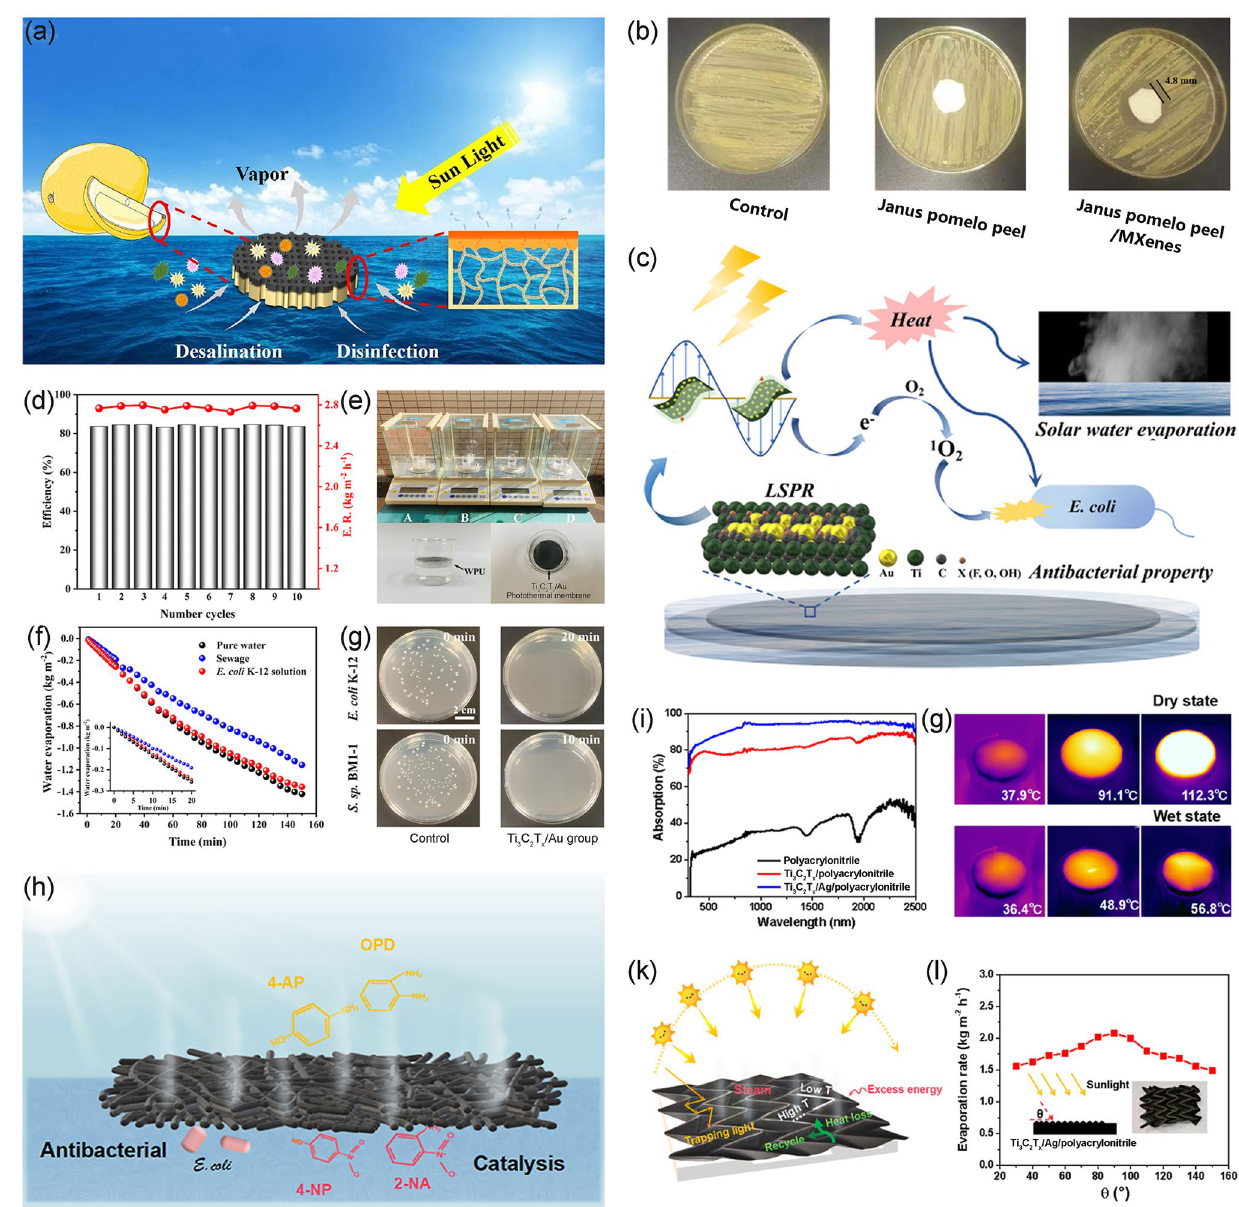
Fig. 12 a Schematic illustration of water evaporation and antibacterial property of Janus pomelo peel/MXenes; b Photographs of diffusion inhi- bition zone tests [155]. Copyright 2021 Elsevier. c Schematic illustration of solar water evaporation and antibacterial property of Ti 3 C 2 T x /Au photothermal membrane; d Solar evaporation rate (right axis) and the corresponding evaporation efficiency (left axis) of Ti 3 C 2 T x /Au photo- thermal membrane over 10 cycles (each cycle sustained over 1 h); e Photograph of the evaporation devices (A: control group, B: pure water, C: sewage from the Pearl River, D: E. coli K-12 solution); f Water evaporation performance of different solution systems; g Colony-forming units images of different bacteria after treatment with Ti 3 C 2 T x /Au photothermal membrane under irradiation [42]. Copyright 2021, American Chemical Society. h Schematic illustration of water evaporation and antibacterial property of Ti 3 C 2 T x /Ag/polyacrylonitrile nanofiber membrane; i Ultraviolet–visible–near-infrared (UV–vis–NIR) absorption spectra in the wavelength range from 300 to 2500 nm; g IR thermal images in the dry and wet state, the left column is polyacrylonitrile nanofiber membrane, the middle column is Ti 3 C 2 T x /polyacrylonitrile nanofiber membrane, and the right column is Ti 3 C 2 T x /Ag/polyacrylonitrile nanofiber membrane; k Schematic illustration of evaporator under different incident angles of sunlight; l Evaporation rate of fabricated Ti 3 C 2 T x /Ag/polyacrylonitrile nanofiber-based origami evaporator under different incident angles of sunlight [44]. Copyright 2021,